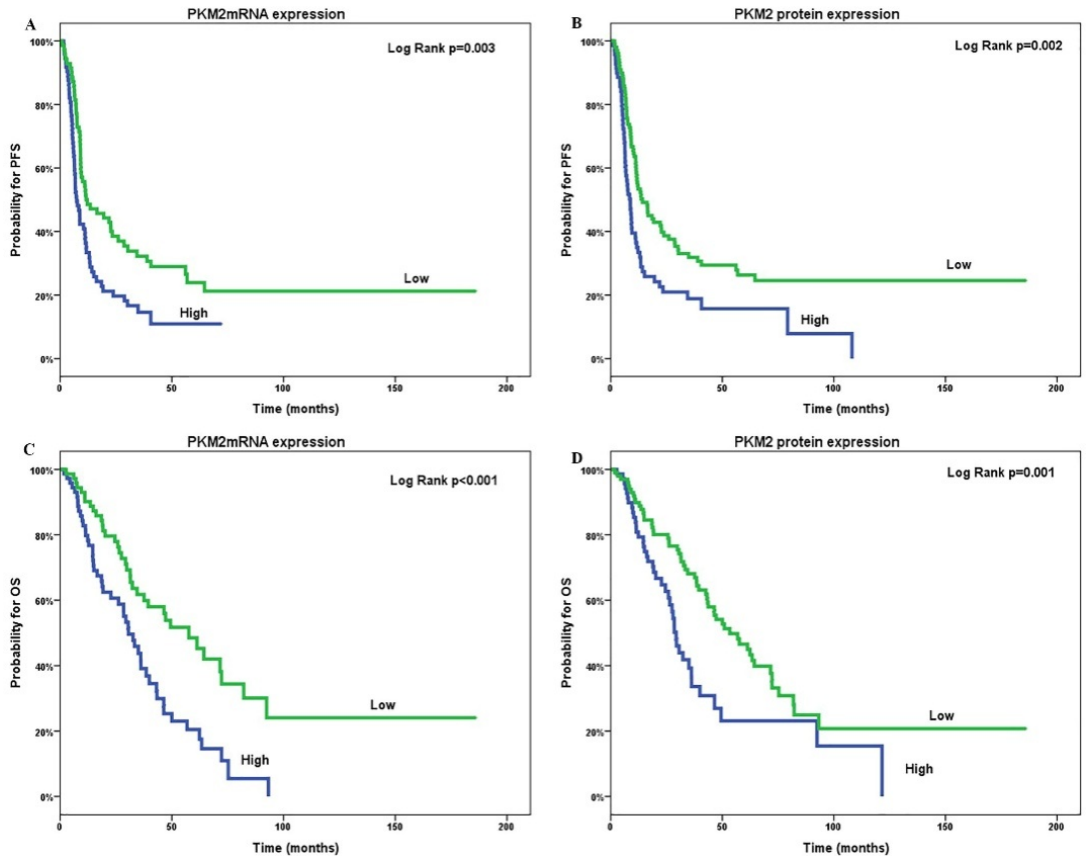
Figure 3. Tumoral PKM2mRNA ( A , C ) and protein expression ( B , D ) associated with progression-free survival (PFS; A , B ) and overall survival (OS; C , D ) of patients with epithelial ovarian cancer. PFS: progression-free survival; OS: overall survival